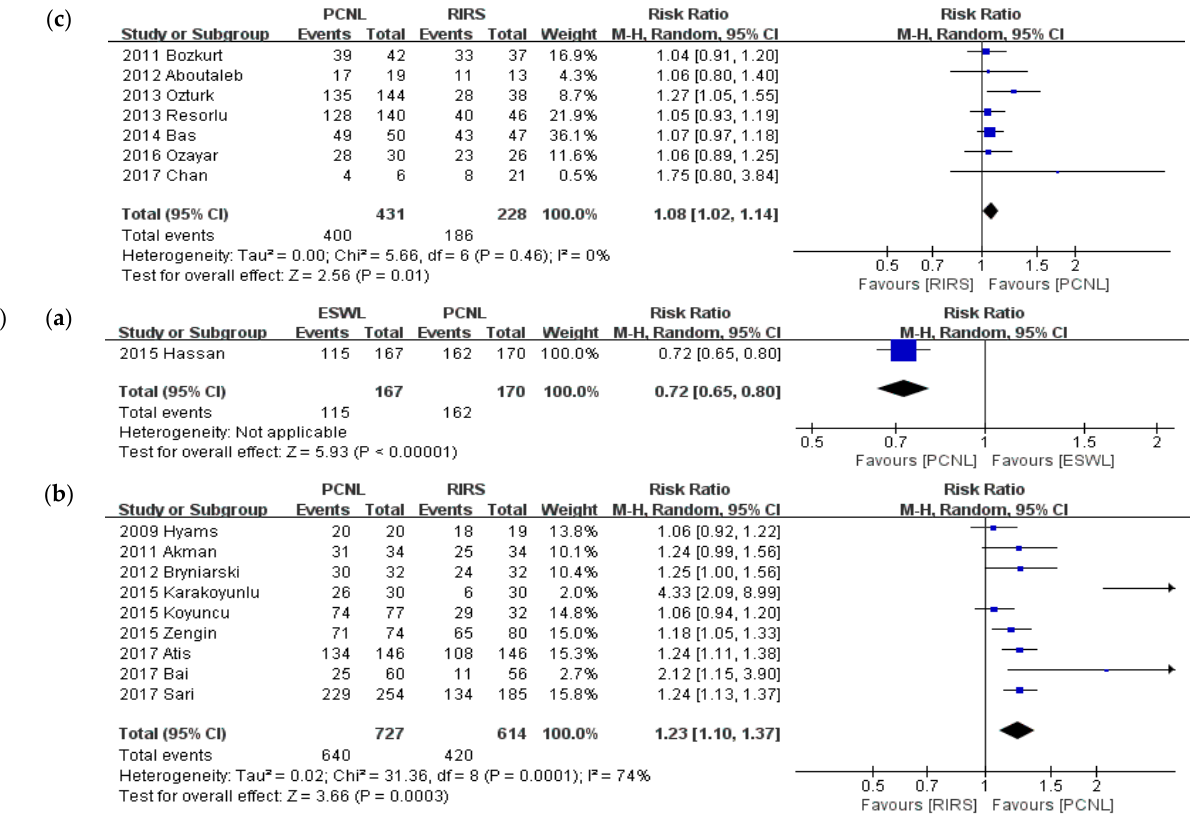
Figure 4. Meta-analysis ( A ). Stone-free rate (stone size ≤ 2 cm): ( a ) ESWL vs. PCNL; ( b ) ESWL vs. RIRS; ( c ) and PCNL vs. RIRS. Meta-analysis ( B ). Stone-free rate (stone size >2 cm): ( a ) ESWL vs. PCNL; and ( b ) PCNL vs. RIRS.